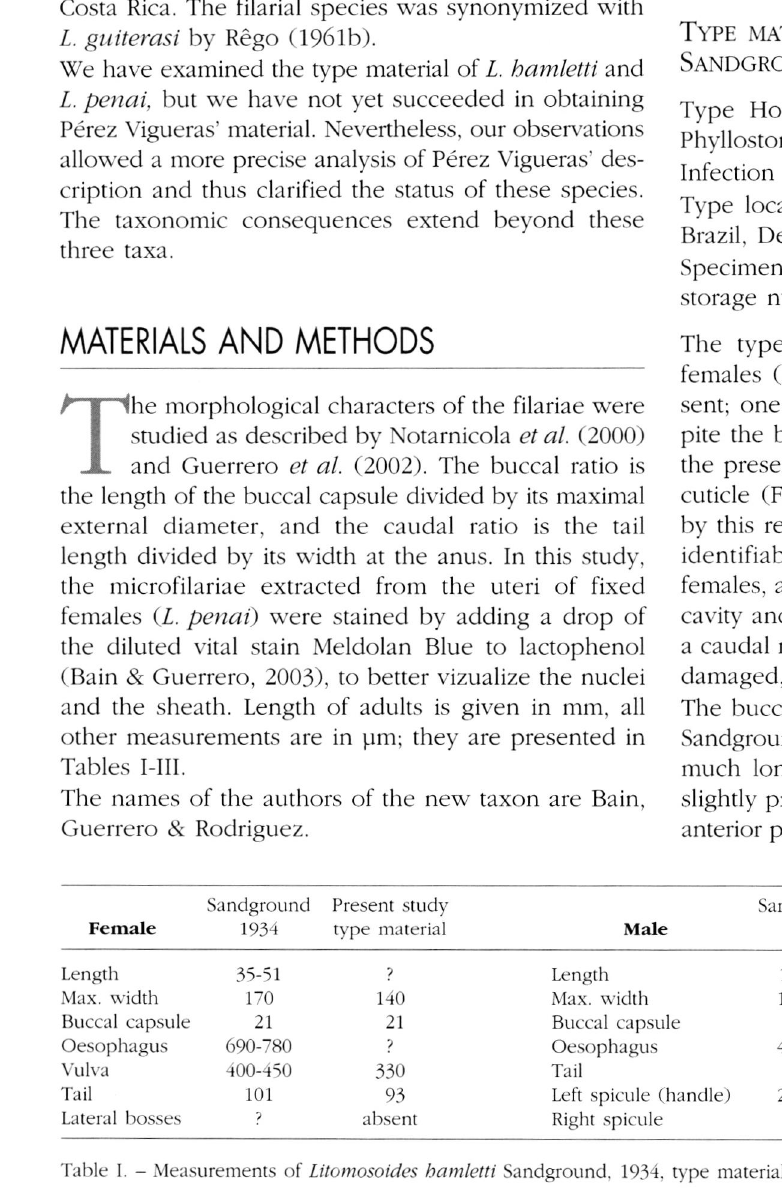
Table I. - Measurements of Litomosoides hamletti Sandground, 1934, type material and material of Chitwood (1938).